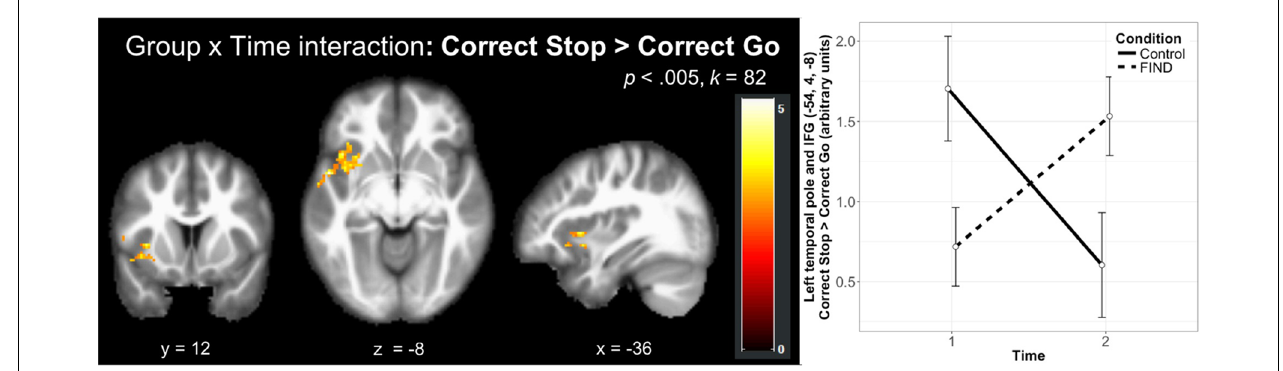
FIGURE 3 | Group by time effects on brain activation during the SST revealed significant clusters in the left temporal pole extending into the left inferior frontal gyrus (IFG) and the left insula that were driven by increases in these regions in the FIND group and decreases in the CTL group over time ( N = 32). This effect is decomposed by group and time on the left panel. Error bars indicate 95% confidence interval.